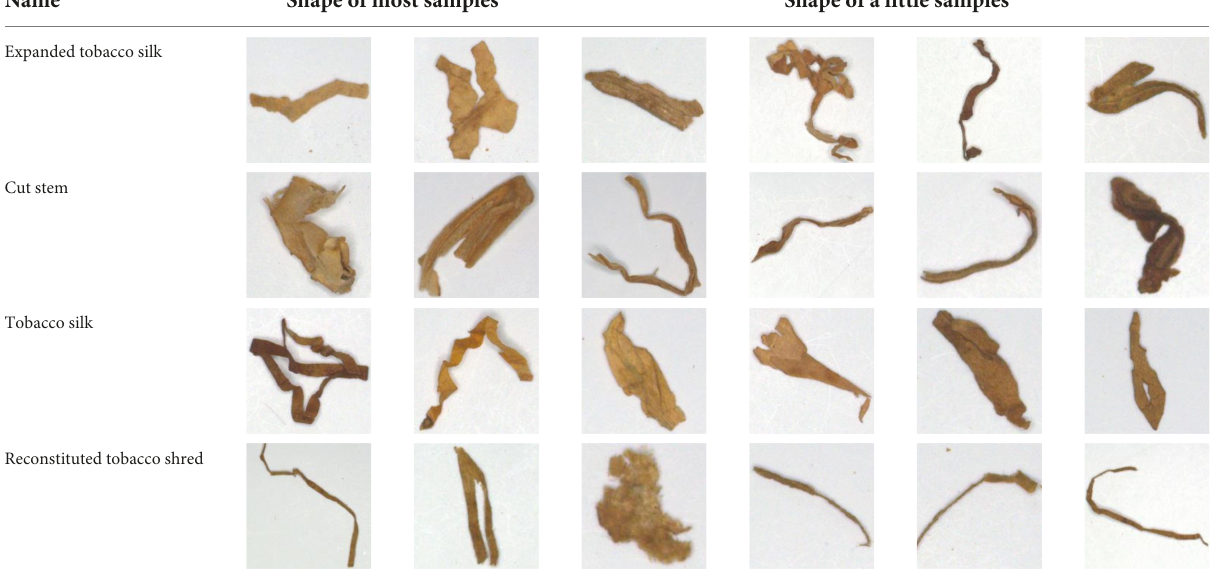
TABLE 6 Tobacco shred shape image table.